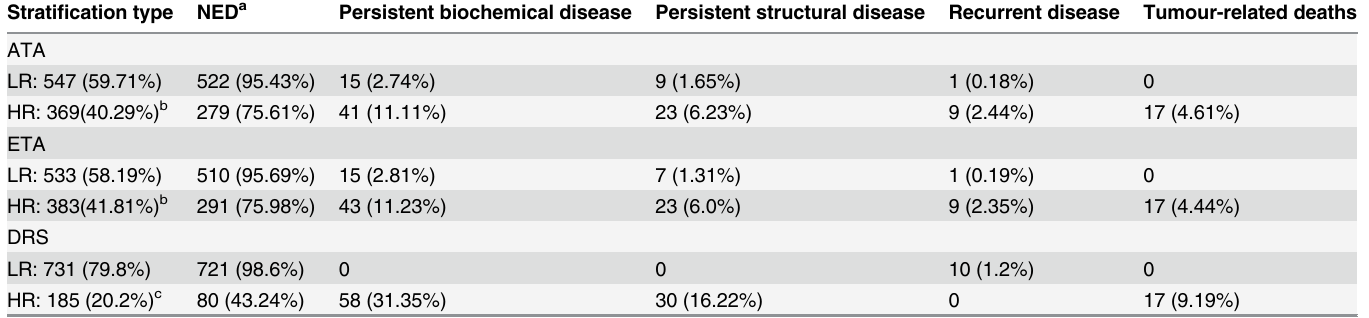
a Gender: F, female b Histology: Fol., follicular; Pap.,papillary; Ins, insular c Follow-up: PS, persistent structural disease; NED, no evidence of disease; PD, persistent biochemical disease. doi:10.1371/journal.pone.0153242.t002 thyroid carcinoma were classified as HR at baseline. Ten of these (56%) had distant metastases at diagnosis. None of the patients entered remission as a result of initial treatment; the disease was considered structurally persistent in 11 patients and biochemically persistent in six. Correlation between the recurrent/persistent disease risk stratification systems and the course of disease The correlation between the ATA, ETA and DRS risk stratification systems and clinical course (NED, persistent disease, recurrent disease or death) is shown in Table 3. For the sake of clarity, patients were classified in two risk groups within each classification system as follows: (1) ATA/LR and HR (IR and HR combined); (2) ETA/LR (very LR and LR combined) and HR; and (3) DRS/LR (excellent response) and HR (indeterminate response, biochemical incomplete response and structural incomplete response combined). According to the ATA and ETA, 95.43% and 95.69%, respectively, of patients in the LR group were classified as NED at the end Table 3. Clinical outcome at the end of follow-up according to the ATA, ETA and DRS systems. Strati fi cation type NED a